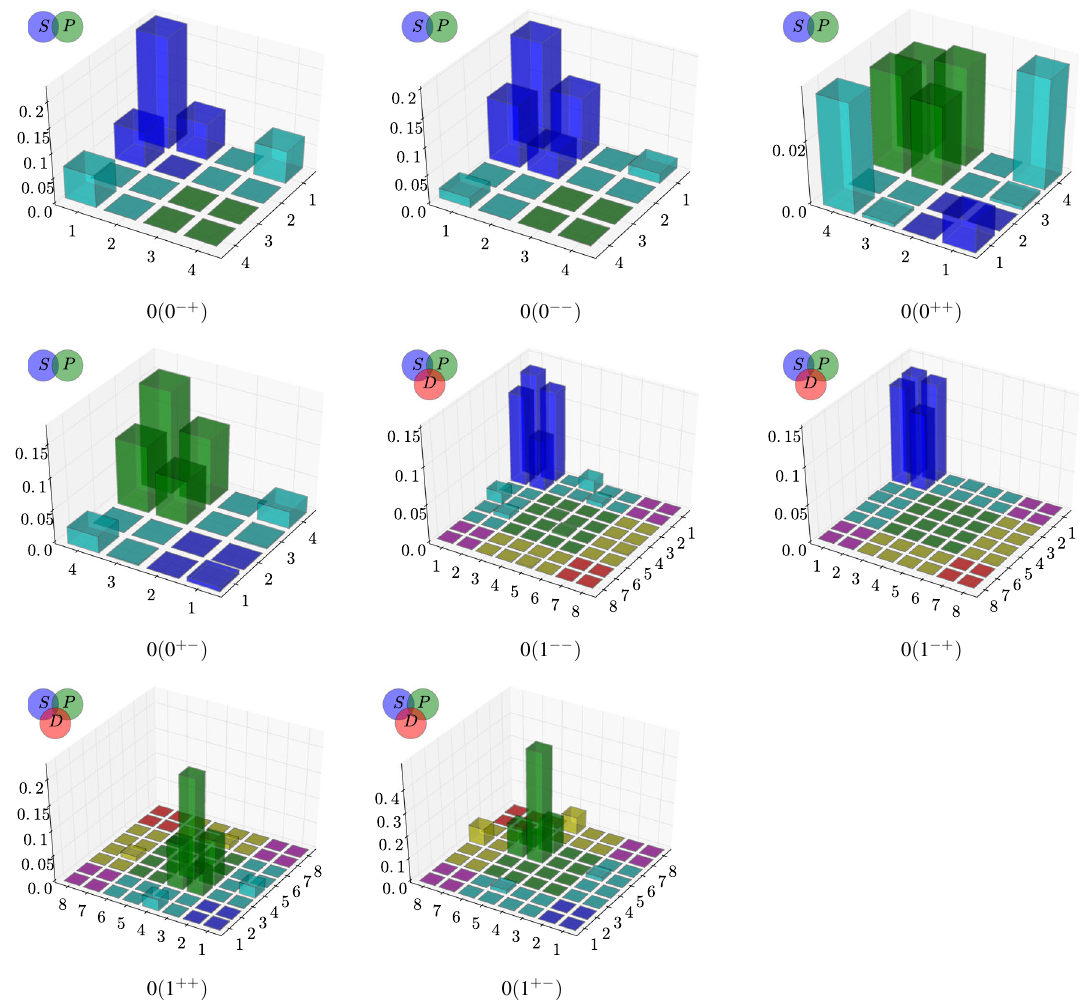
Fig. 7 Orbital angular momentum decomposition of ground-state mesons. Horizontal axes are labeled by indices of covariants as given in Eqs. (A.8)–(A.11). The vertical axis gives the percentage of the squared contribution of each respective covariant combination plotted by a bar